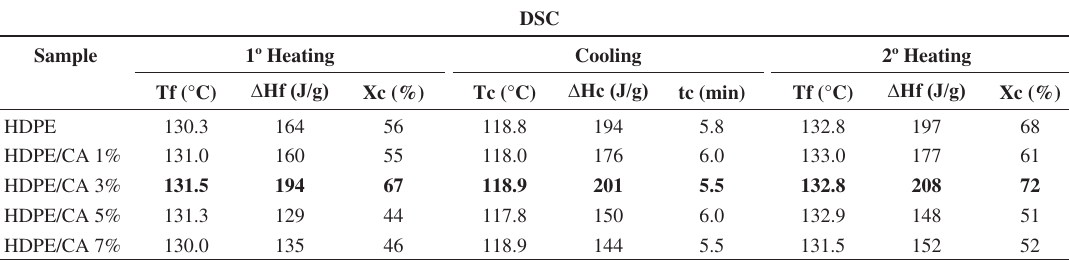
Table 2. Thermal behavior of HDPE without and with different concentrations from